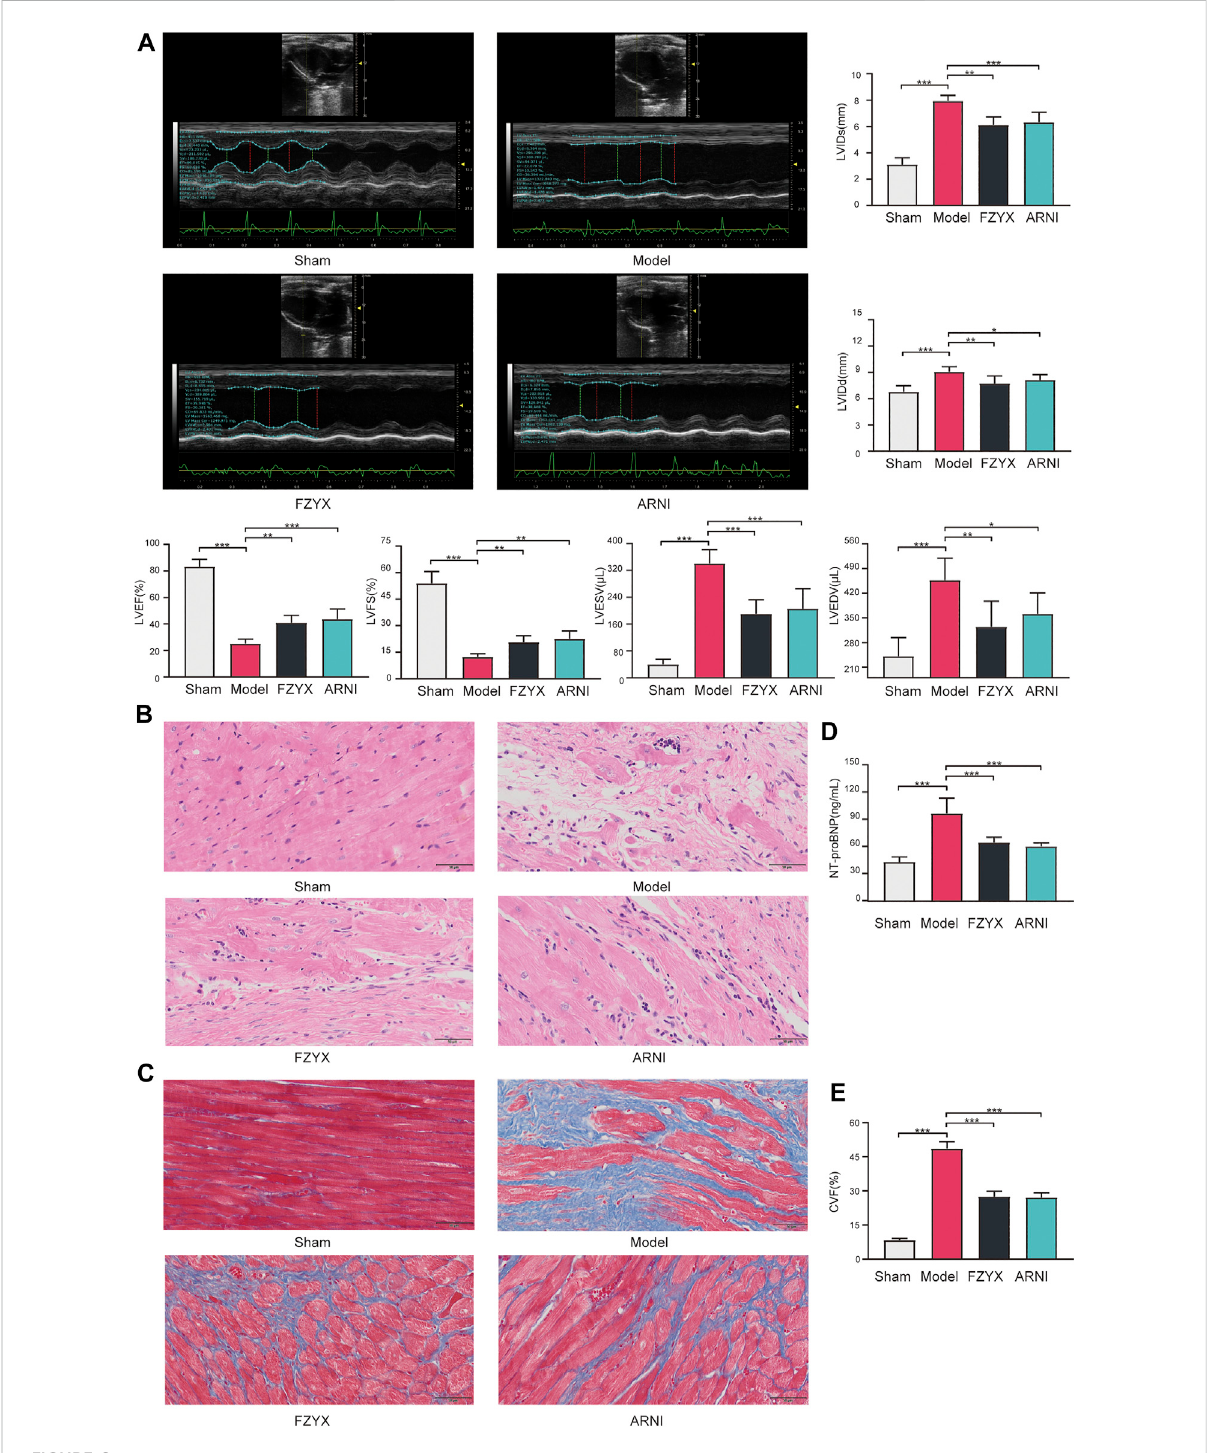
FIGURE 6 Effects of FZYX on cardiac function and structural alterations in HF model rats. (A) Echocardiographic results ( n = 5). Statistical analysis was performedincludingtheLVEF,LVFS,LVESV,LVEDV,LVIDsandLVIDd. (B) HEstaining. (C) Masson ’ sstaining. (D) NT-proBNP( n =5). (E) CVF( n =5)* p < 0.05, ** p < 0.01, *** p < 0.001 vs.